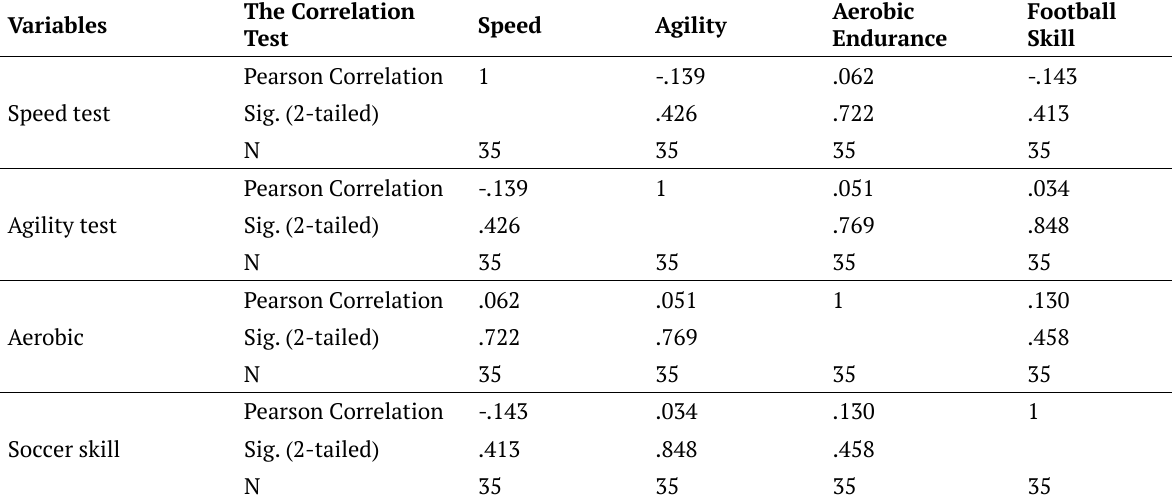
Table 8. The Correlation Test’s Result